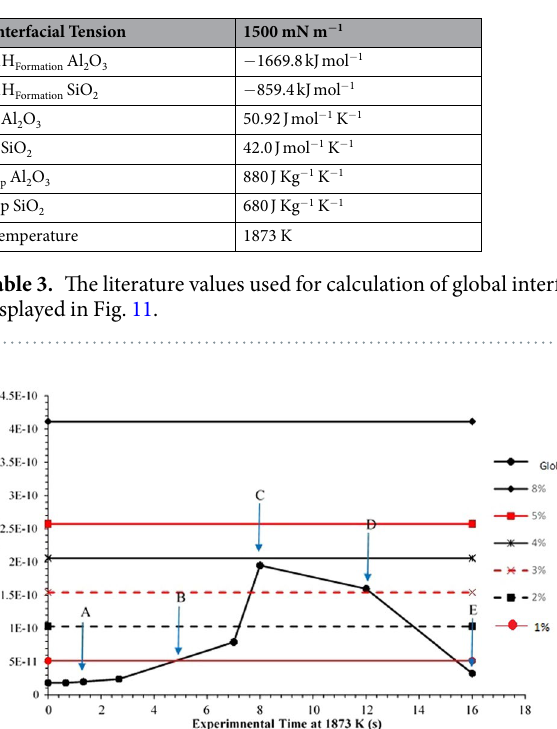
Figure 11. The global interfacial tension during the increase and reduction of interfacial area as measured for the 8% FeAl sample coupled with the free energy gain of reaction to equilibrium for the 8, 5, 4, 3, 2, and 1% FeAl systems. Period A is during initial light perturbation, B during heavy perturbation, C fully emulsified, D ongoing coalescence and E a fully coalesced